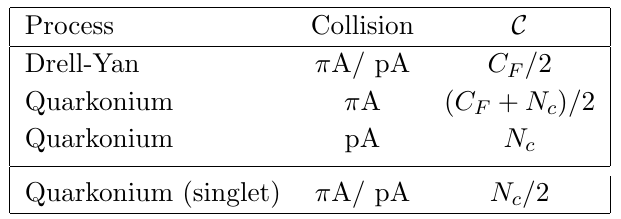
Table 1 . Color factors assumed in the present analysis for Drell-Yan and color octet quarkonium production in (cid:25) A and pA collisions. The assumption regarding the case of color singlet quarkonium production is discussed in section